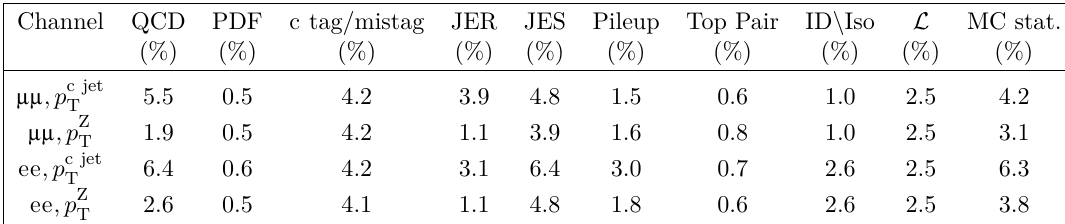
Table 5 . Summary of the systematic uncertainties in the integral fiducial cross section arising from the various sources for electron ( ee ) and muon ( mm ) channels, calculated by integrating over p c jet or p Z T